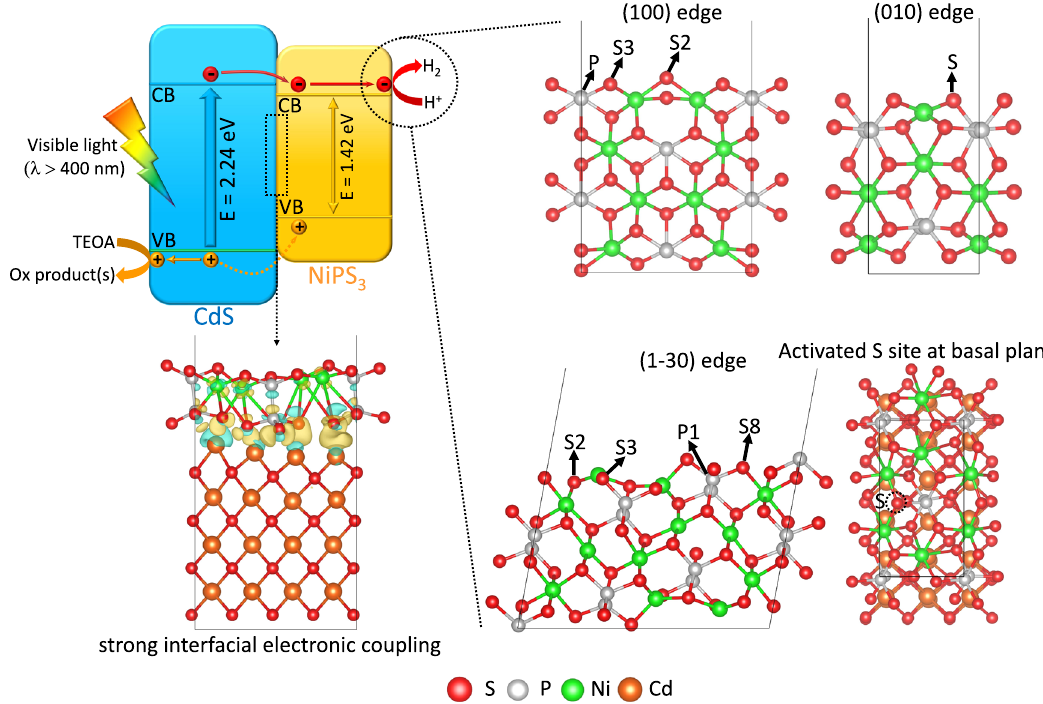
Fig. 7 | Schematic illustration of photocatalytic H 2 -production mechanism in NiPS 3 /CdS system. The visible-light excitation ( λ >400nm), separation/migration of photogenerated electrons and holes, and the surface catalytic reactions of NiPS 3 /CdS system are shown in the fi